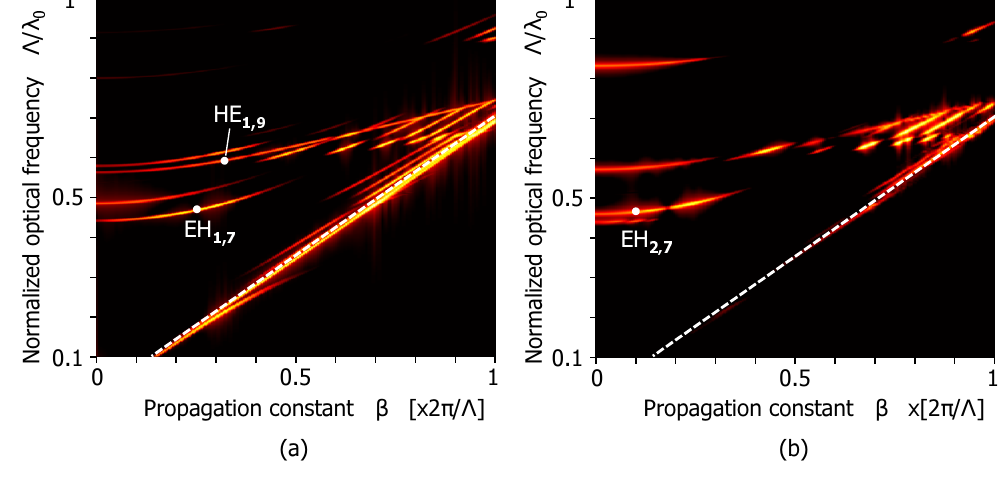
Figure 6. Dispersion relations of the modes with non-zero azimuthal ( (cid:18) ) mode numbers. ( a ) EH and HE modes; ( b ) EH and HE 1 ;n 1 ;n 2 ;n 2 ;n